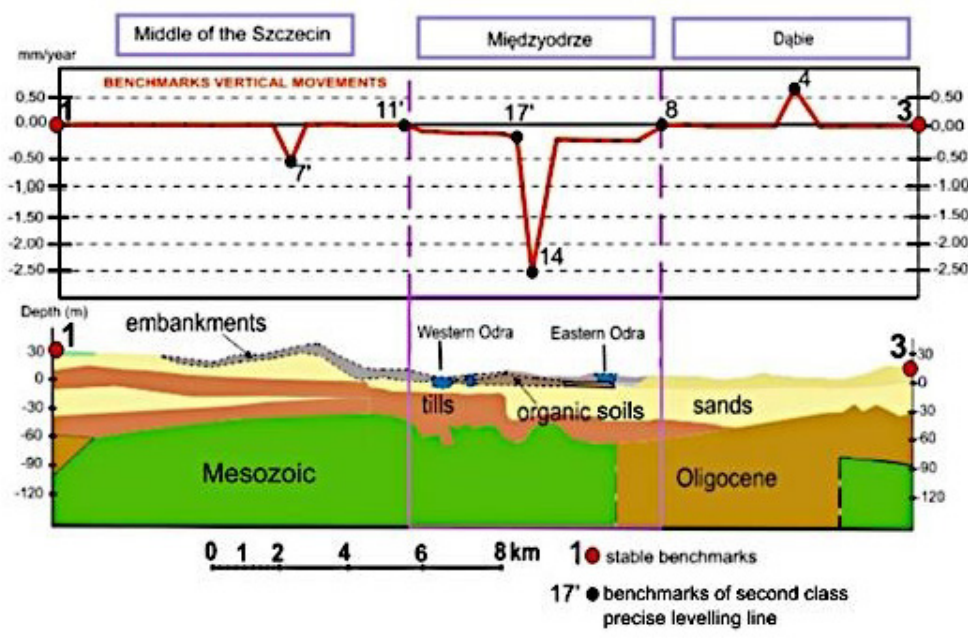
Figure 3. Geological cross-section with vertical movements of benchmarks between stable points.